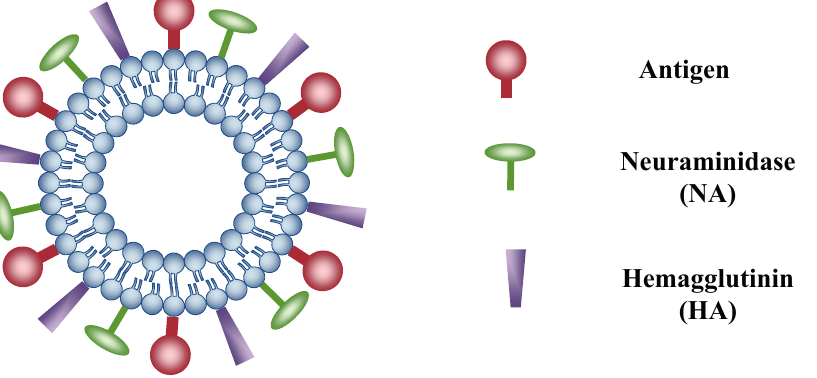
Figure 4. Structure of virosome. The surface of a liposome is decorated with viral surface proteins such as neuraminidase (NA), hemagglutinin (HA) and other